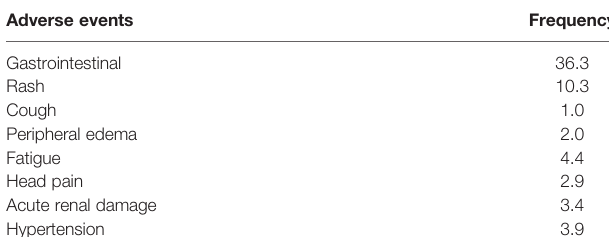
TABLE 3 | Adverse events to Letermovir. The frequency is given in percentage.